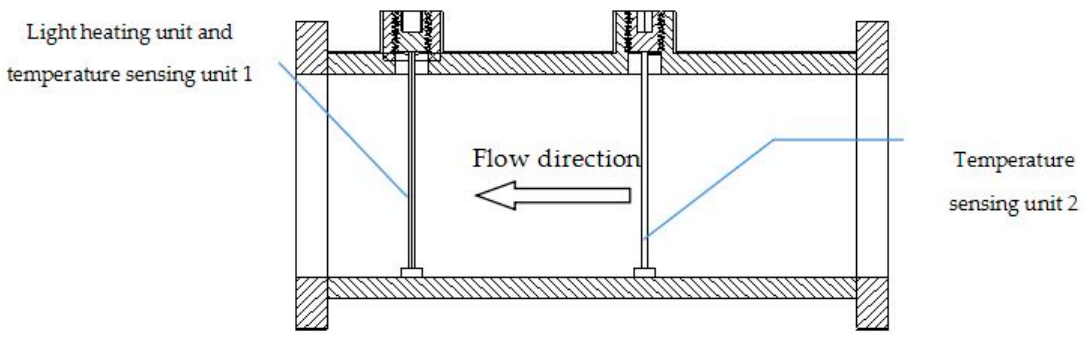
Figure 2. Optical thermal gas flow sensor.